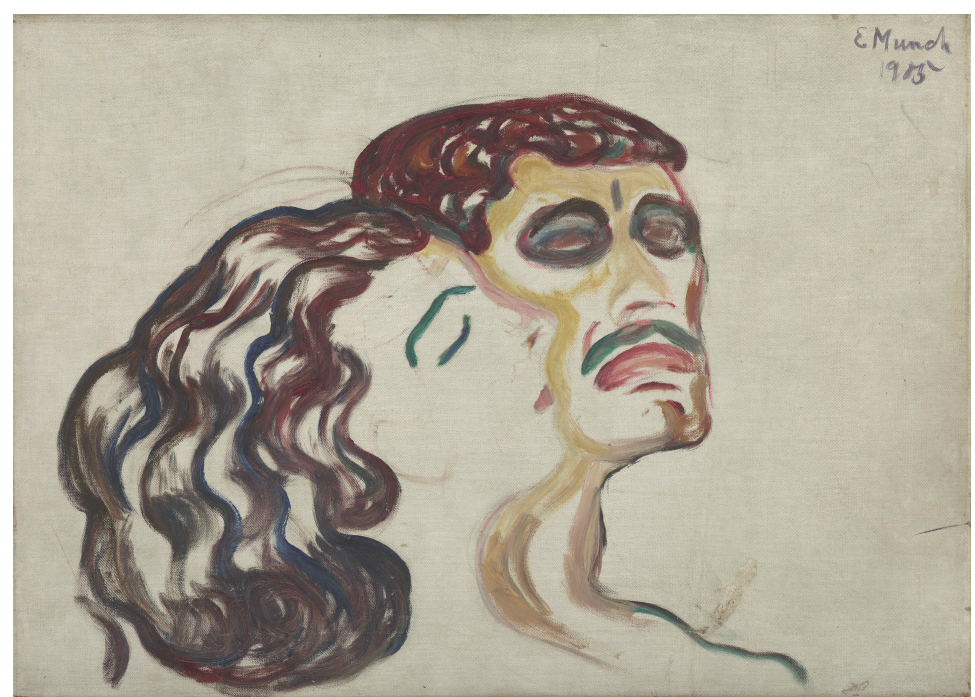
Figure 9: Head by Head (1905) ©